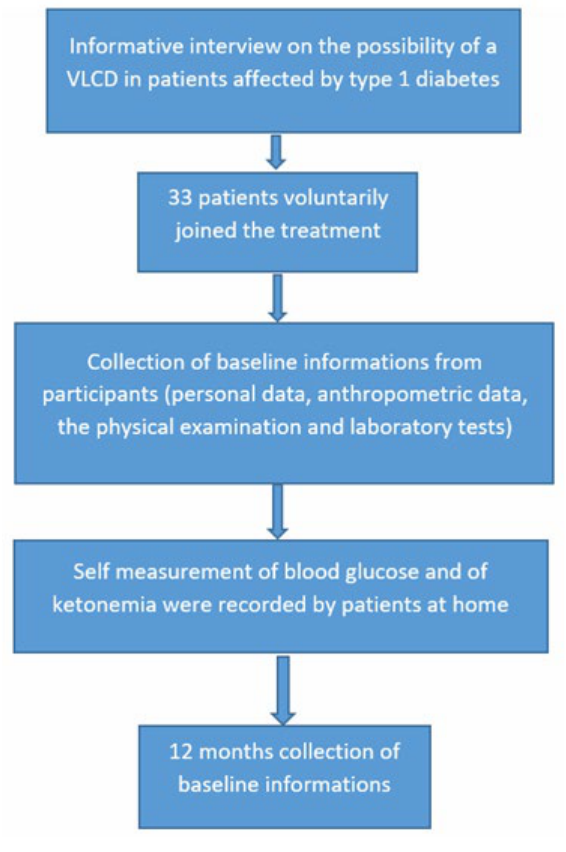
Figure 1. Flow chart of the study.